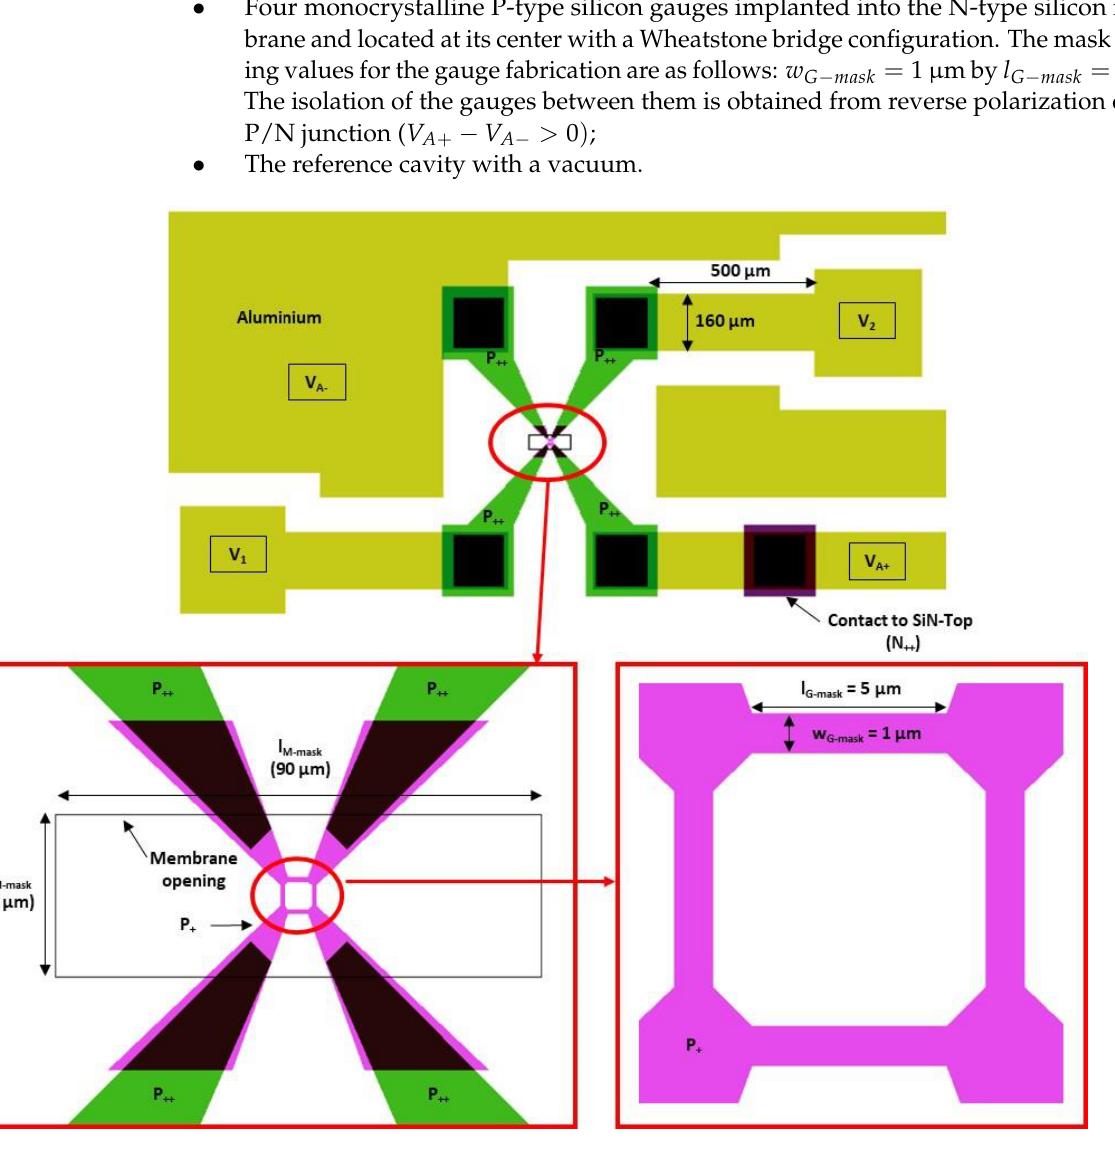
Figure 10. ( a ) Top view of the Wheatstone bridge reported at the center of the membrane surface; ( b ) cross-sectional view of the transducer. 4.2. Technological Process The pressure transducers were fabricated on silicon-on-insulator (SOI) wafers, whose characteristics are given in Table 3.